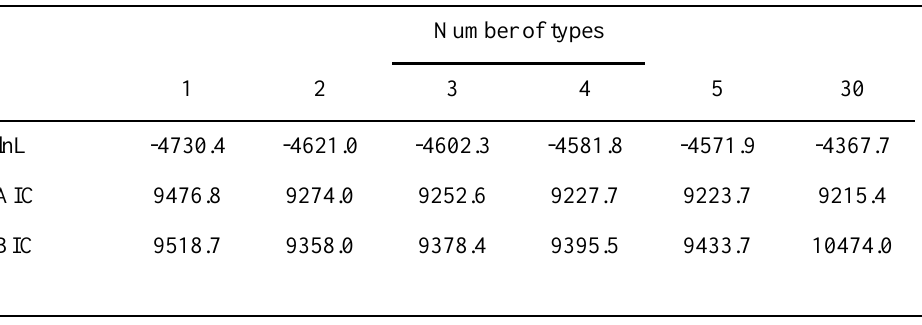
Table 6 . The value of maximum likelihood (InL), Akaike Information Criterion (AIC), and Bayersian Information Criterion (BIC) for different numbers of types distinguished by maximum likelihood estimation using the method of El-Gamal and Grether (1995) for 40/60-round